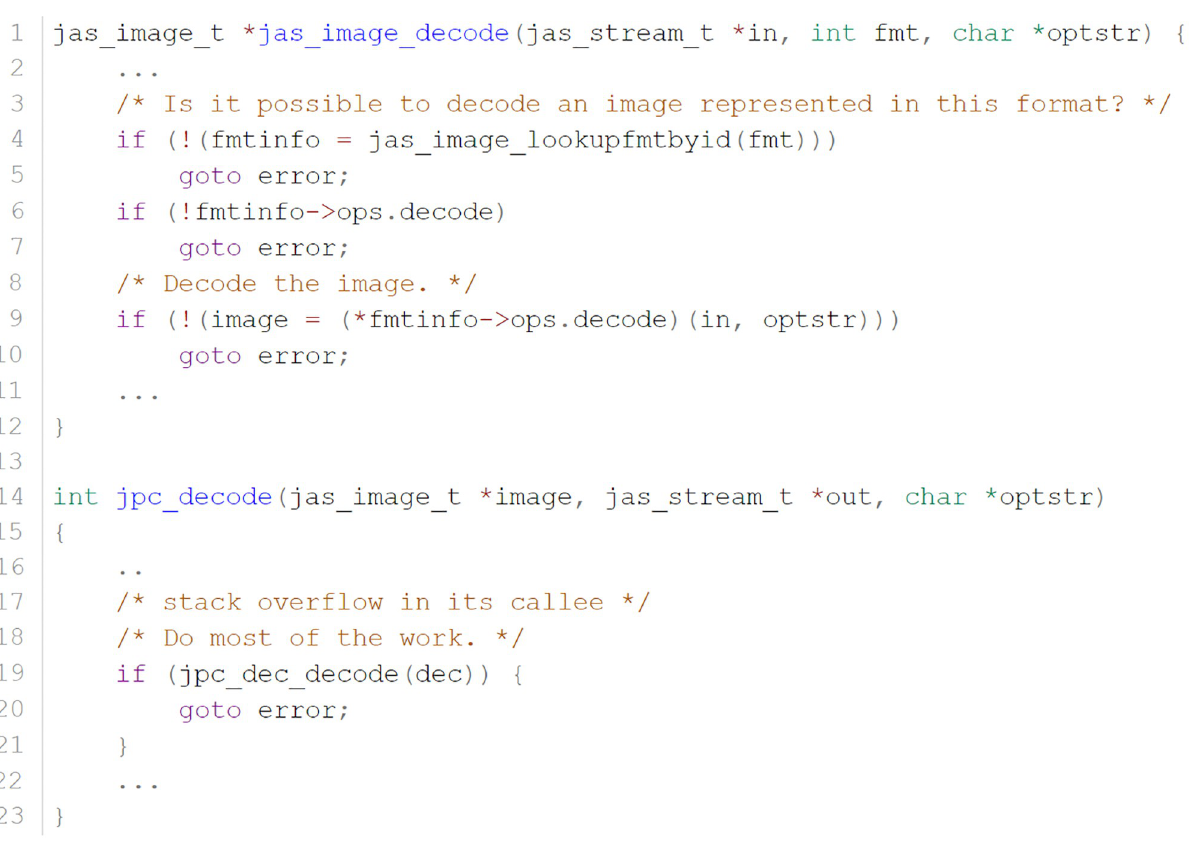
Fig 2. AFLGo may prefer the wrong seed in the program. A is the function entry point, and O and K are the target basic blocks, respectively. A.CFG of program B.execution trace of seed 1 C.execution trace of seed 2 D.execution trace of seed